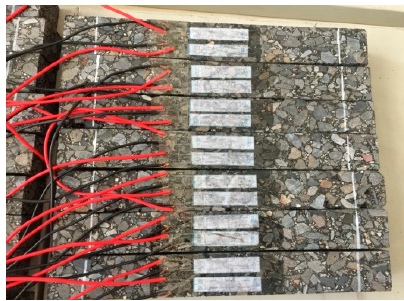
Figure 4. Test beam. Materials 2019 , 12 , x FOR PEER REVIEW